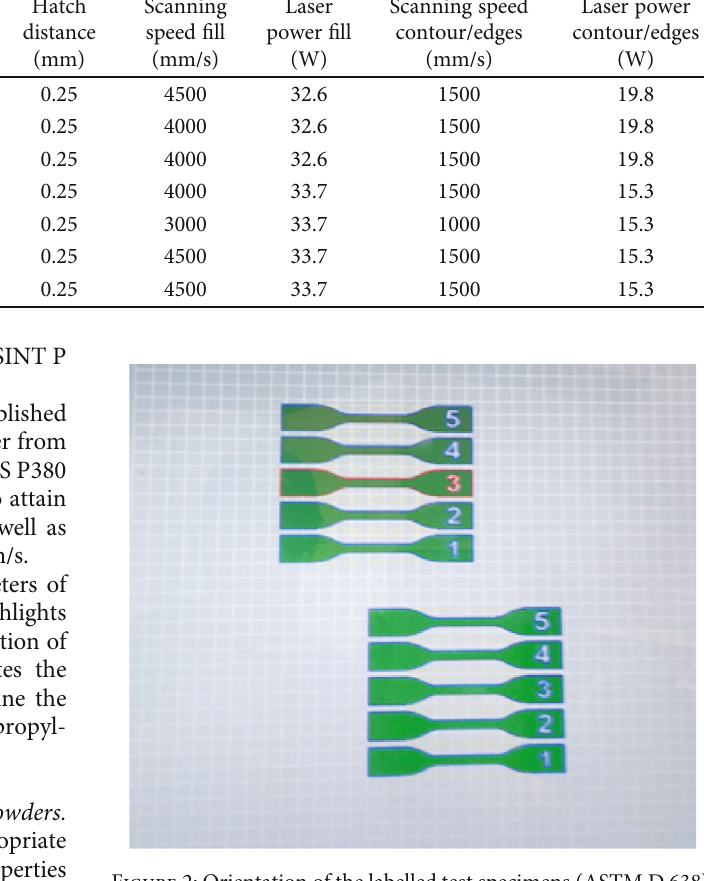
Table 2: Test parameters to determine the best removal chamber and building chamber temperatures for Laser PP CP 60 powder. Temp. of the Cycle